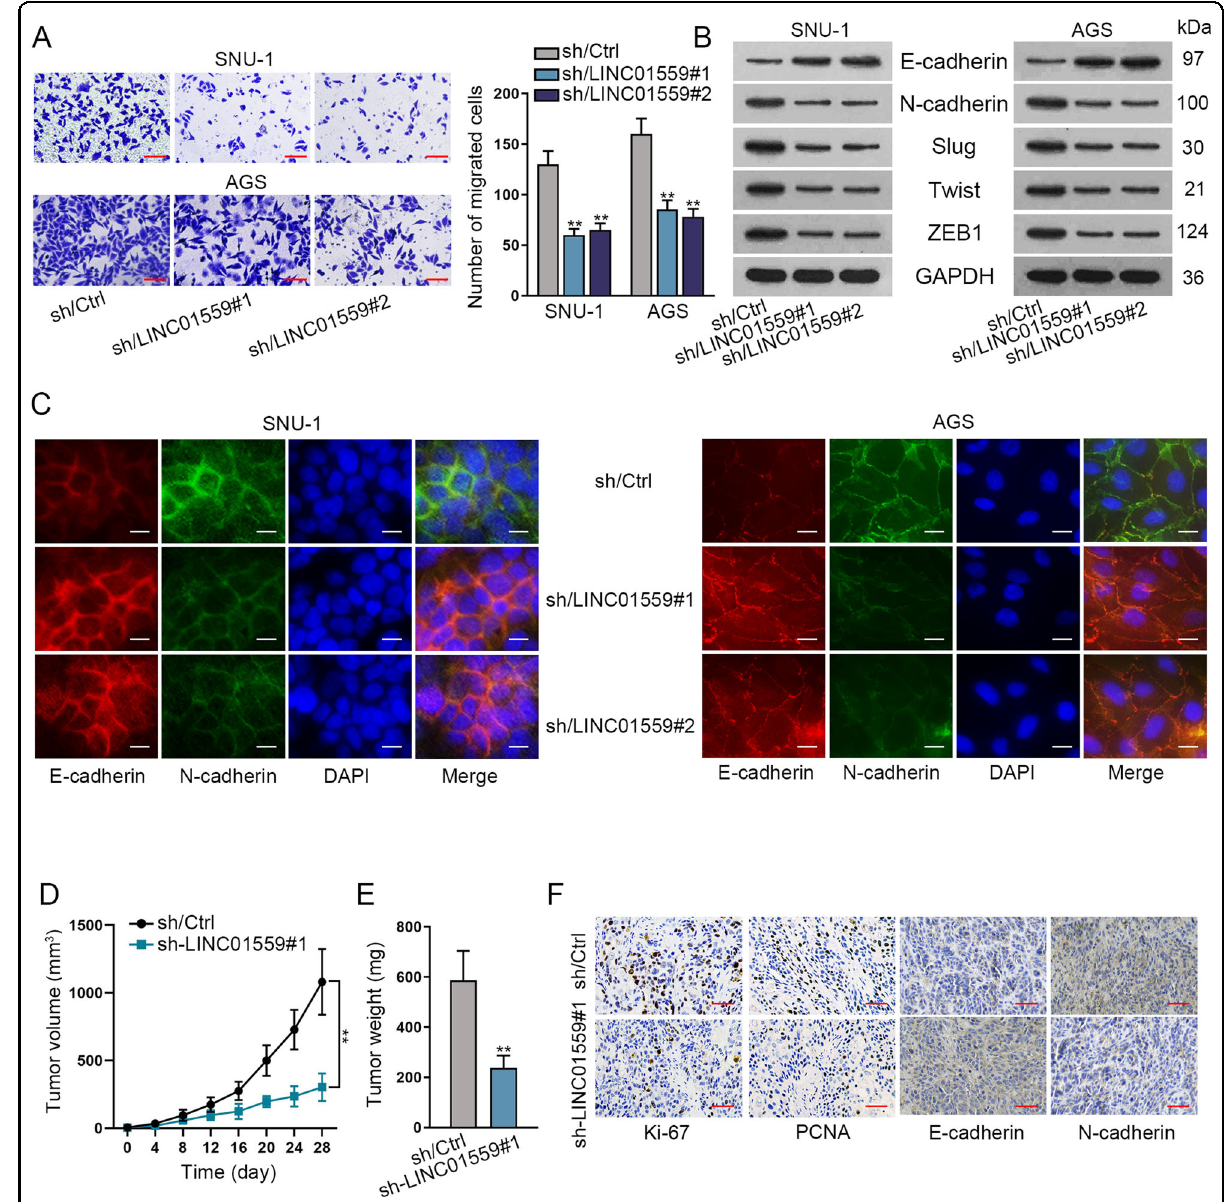
Fig. 2 LINC01559 silencing inhibits the in vitro migration and EMT process and in vivo tumor growth of GC cells. A . Transwell experiment assessed the migration ability of GC cells after the interference of LINC01559. B , C Western blot and immuno fl uorescence experiments examined the impact of the interference of LINC01559 on the EMT process in GC cells. D , E The growth rate and weight of in vivo tumors originated from GC cells with or without LINC01559 knockdown. F Immunohistochemical experiment analyzed the staining of Ki-67, PCNA, E-cadherin and N-cadherin in above tumors. ** P <